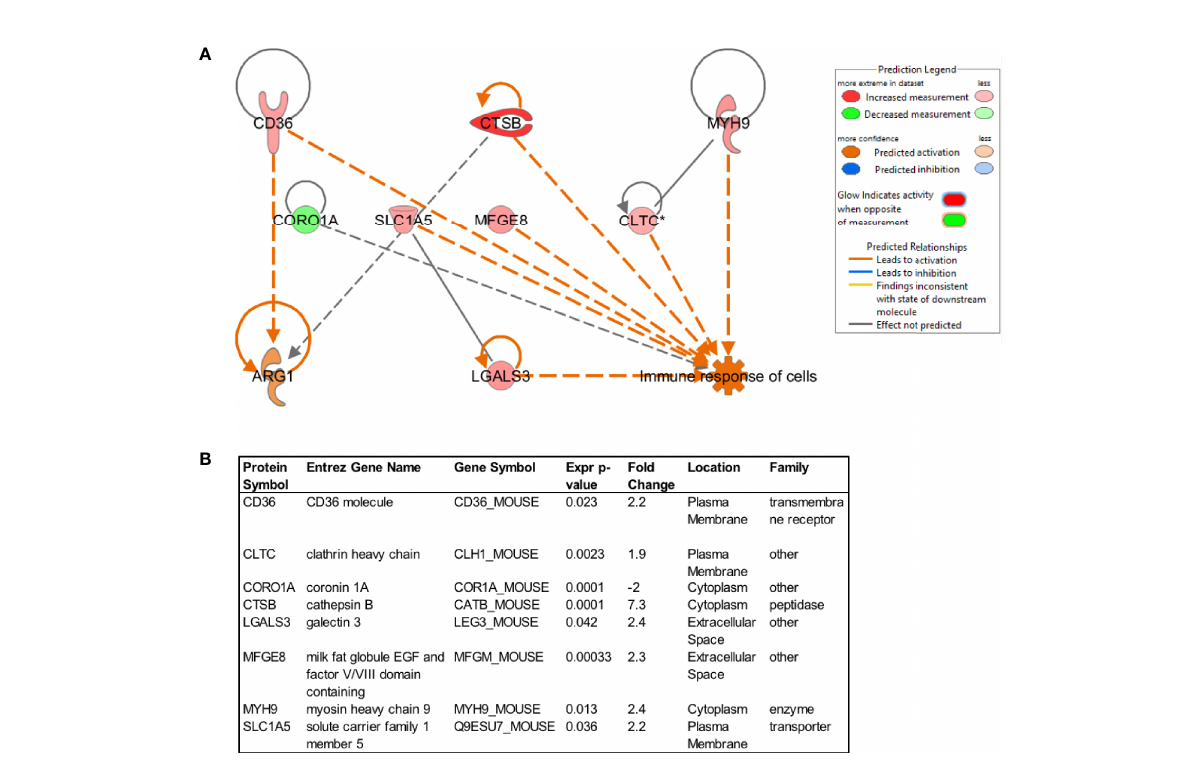
FIGURE 4 Prediction of downstream molecules and functions regulated by proteins in EVs derived from L. donovani -infected macrophages (72 hpi). The proteins associated with vesicles produced by uninfected or infected RAW264.7 macrophages were analyzed by quantitative mass spectrometry, followed by analysis using Ingenuity Pathway Analysis. The downstream functions and molecules of vesicular proteins that were upregulated (red) or down-regulated (green) were analyzed, determining the predicted upregulation of